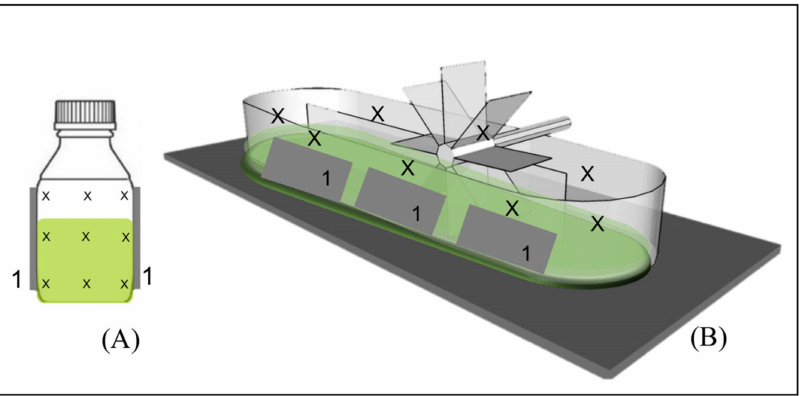
Figure 2. Scheme of the photobioreactors used for A. platensis SAG 2199 ( A ), C. fusca and Spirulina sp. ( B ) assays. 1 represents the ferrite magnets place in the photobioreactors; X represents the SMF measure- ments